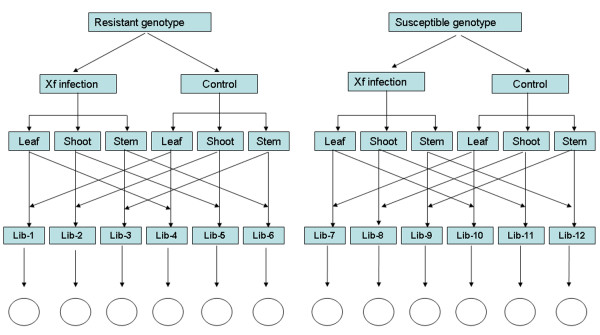
Strategy for SSH library construction. Twelve reciprocal tissue specific (stem, leaf and shoot) SSH cDNA libraries from highly resistant (9621-67) and highly susceptible (9621-94) sibling selections from a Vitis rupestris × V. arizonica population segregating for resistance to X. fastidiosa infection.